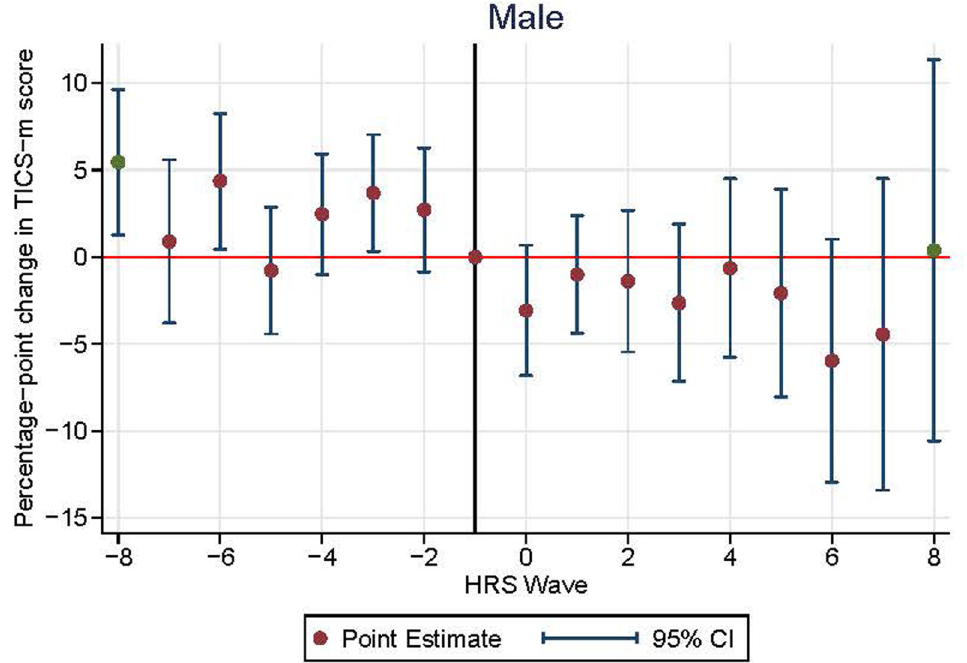
Fig 3. Event study plot for male participants.